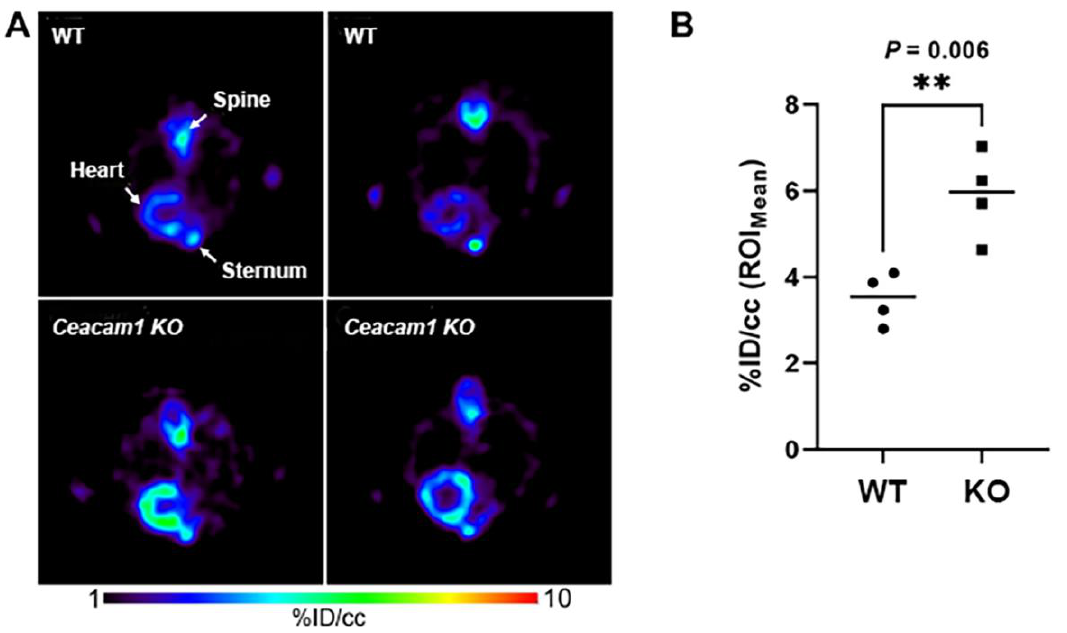
Figure 3. Differential heart muscle uptake/retention of [ 18 F]FTO in WT and Ceacam1 − / − mice. ( A ) Representative transverse MPR PET images at 35 min p.i. of WT and Ceacam1 − / − mice hearts at age 15 – 18 weeks. ( B ). ROI quantification of heart muscle in the two groups ( n = 4 per group, ** p = 0.006).